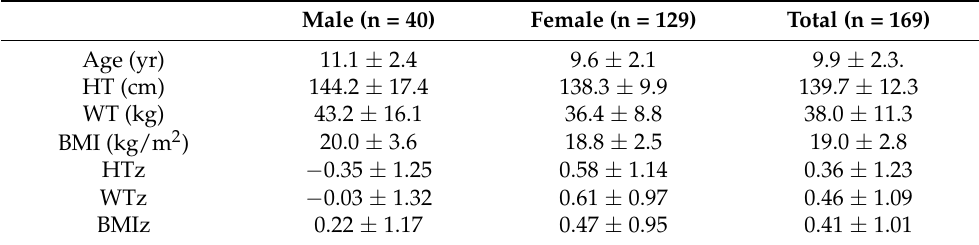
Table 1. The characteristics of the study populations at the first visit (D1).